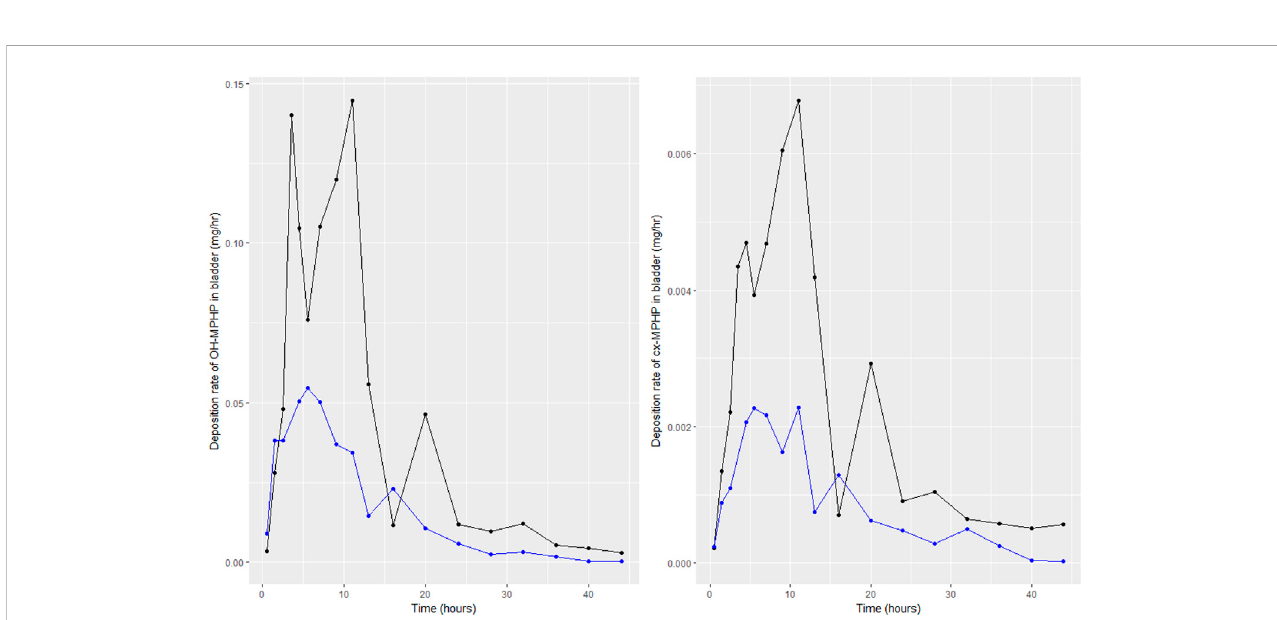
FIGURE 4 DataonratesofthedepositionofOH-MPHPandcx-MPHPintothebladder,calculatedforindividualsC(bluelineandpoints)andE(blacklineandpoints) from the data of Klein et al. (2018). Panel (A) shows the pro fi les of OH-MPHP; panel (B) shows the pro fi les of